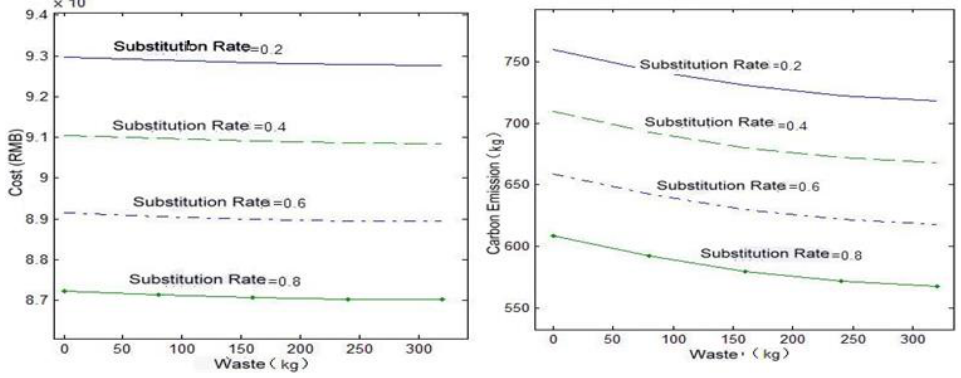
Figure 3. The Pareto Boundaries with Different Cost Substitute